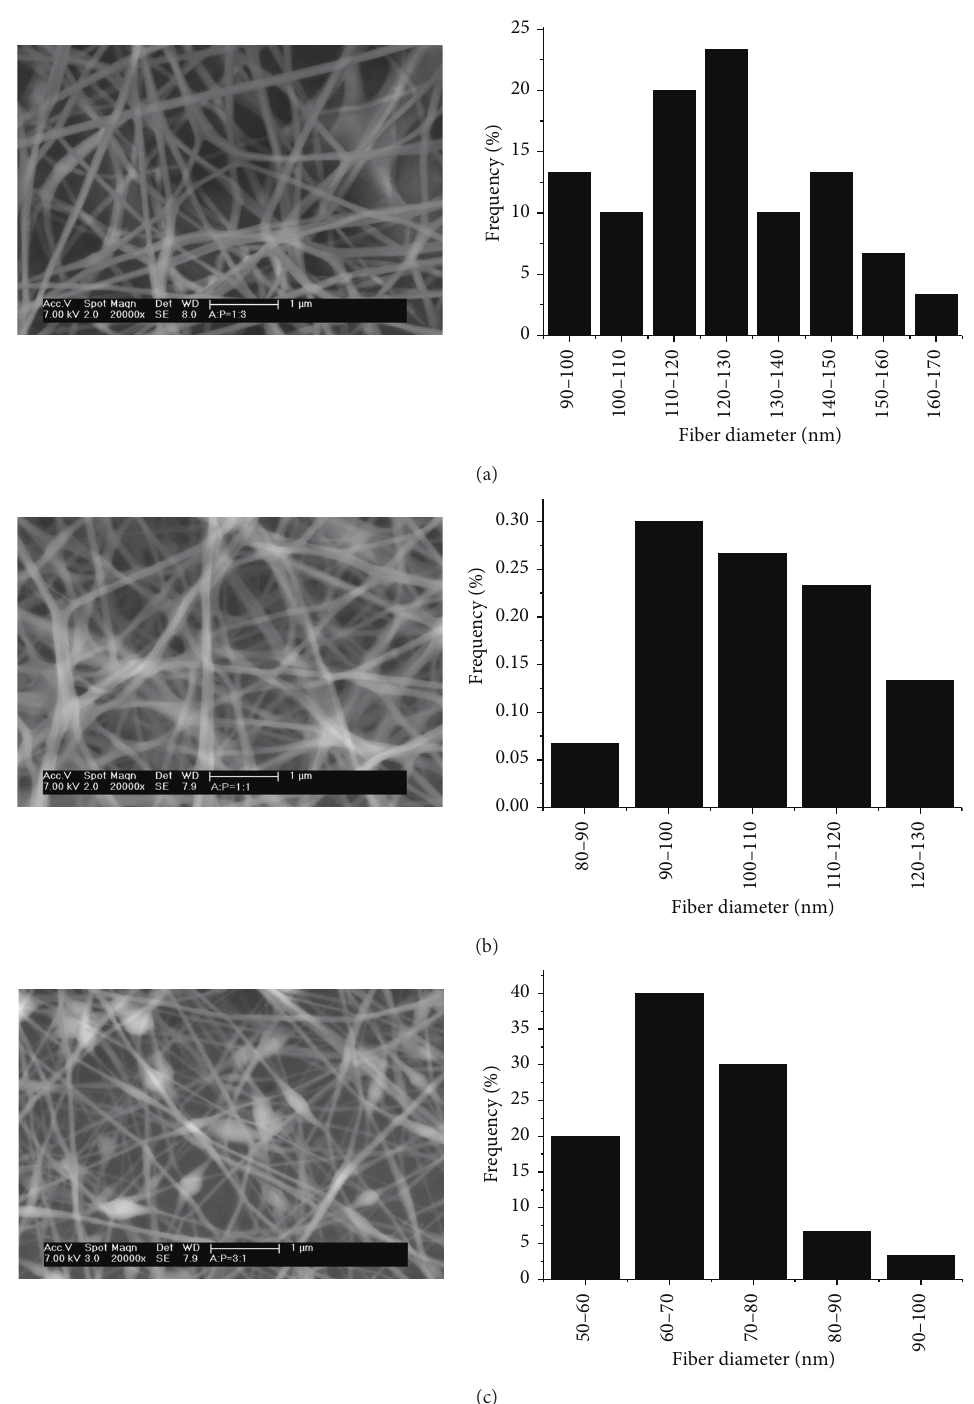
Figure 5: Effect of the NaAlg/PEO ratio on fiber morphology and diameter distribution with 5% solution concentration (magnification = 20,000x). NaAlg/PEO ratio: (a) 1:3; (b) 1:1; (c) 3 :1.